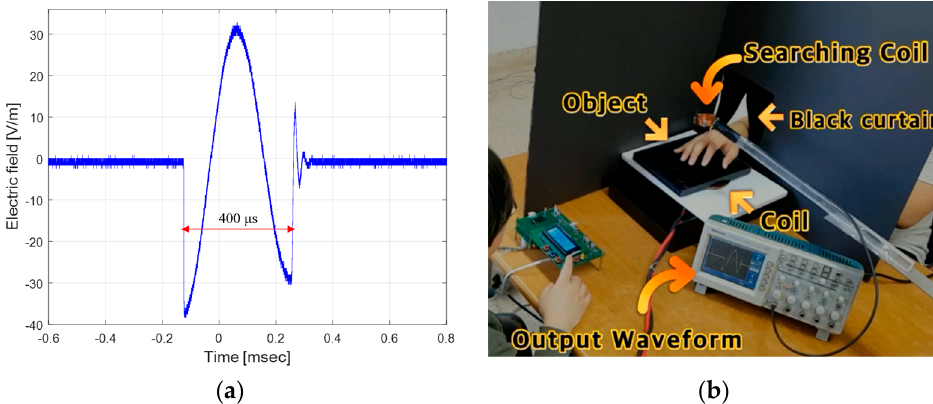
Figure 5. Testing the tactile stimulator based on time-varying magnetic field: ( a ) Induced electric field waveform measured by searching coil. ( b ) Experimental environment for testing the TSTM and measuring electric field.